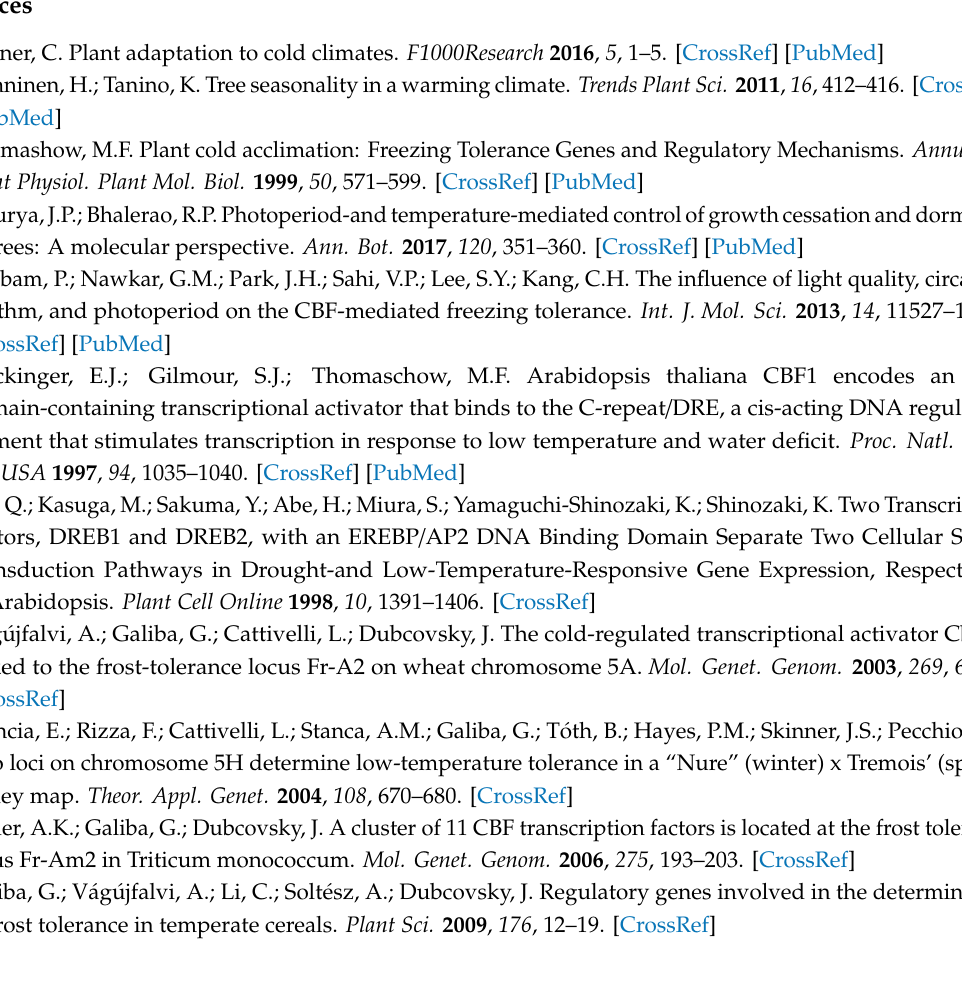
Figure S1: Spectral composition of modulated light treatments at 125 µ mol m − 2 · s − 1 intensity, Figure S2: Spectral composition of modulated light treatments at 250 µ mol m − 2 · s − 1 intensity Figure S3: Spectral composition of modulated light treatments at 350 µ mol m − 2 · s − 1 intensity. Table S1: Primer sequences and